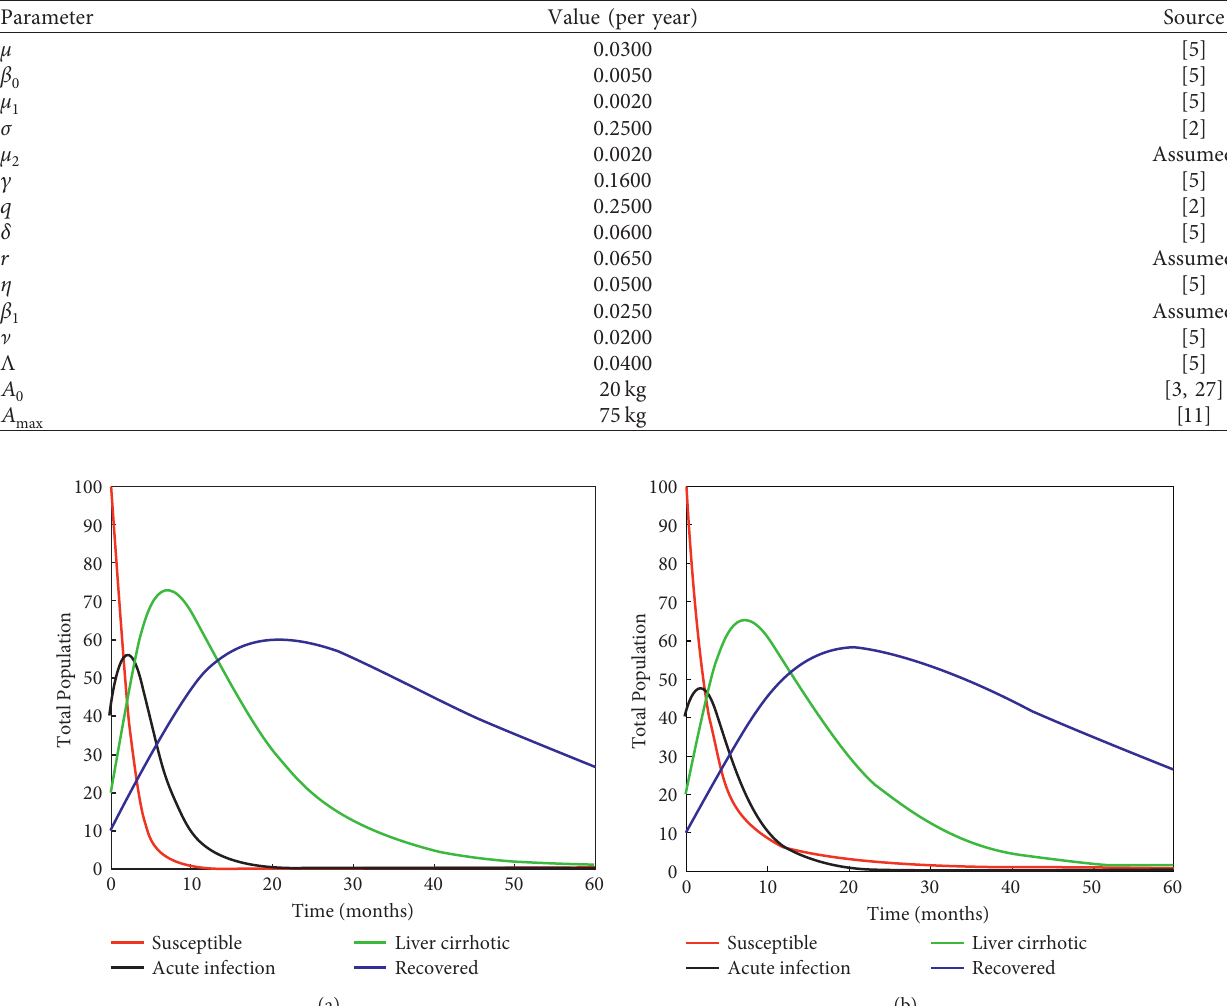
Table 2: Model parameter’s value and source.